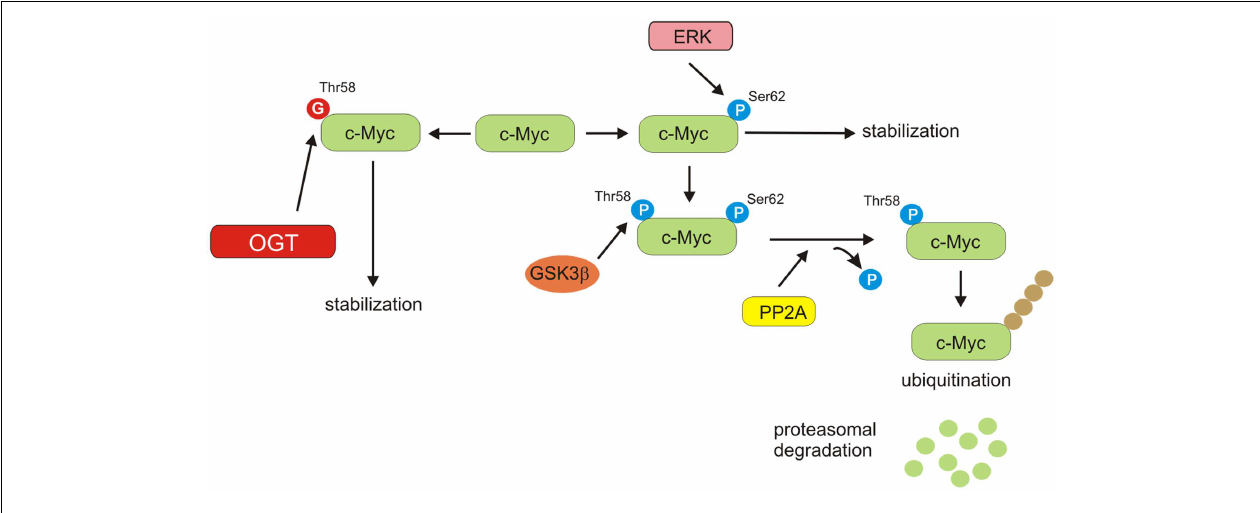
mono-phosphorylated c-Myc is a target for ubiquitin ligase complex, leading to proteasomal degradation. O -GlcNAcylation ofThr58 can compete with phosphorylation and potentially increase stability of